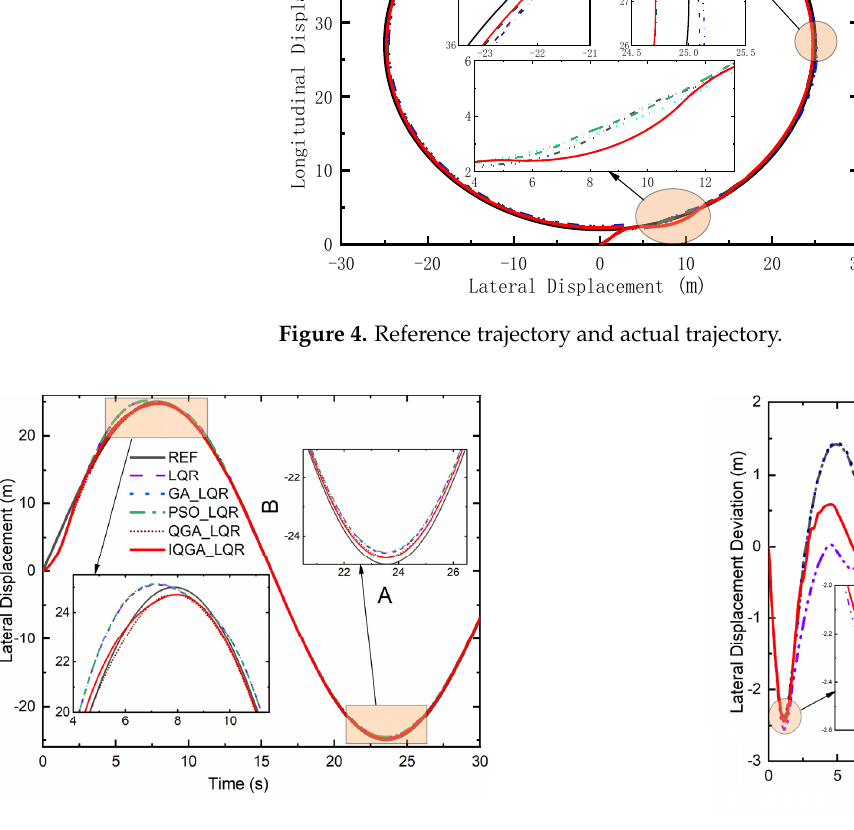
Figure 5. Lateral displacement and deviation.